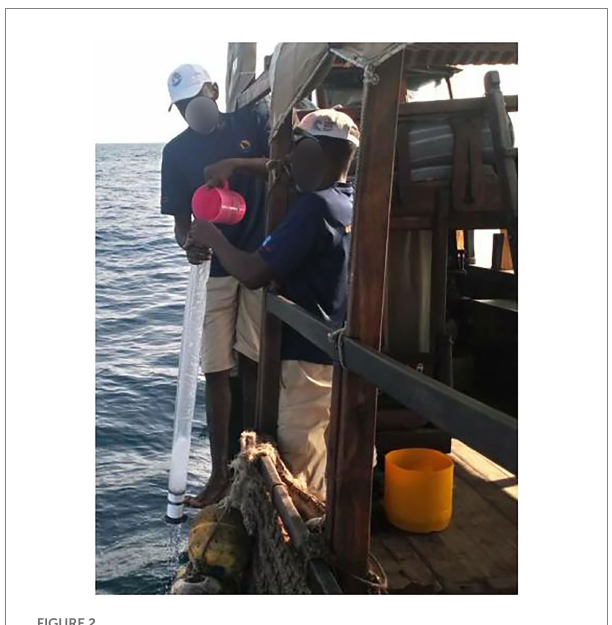
FIGURE 2 AeroPress ® sampling device in use by local citizens.